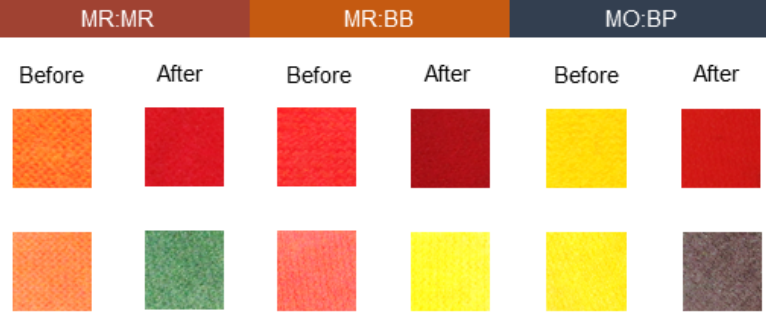
Figure 9. Sensitivity of cotton knits functionalized with different pH sensors to a basic environment created by 35% ammonia and hydrochloride acid solutions. The sensors used were: methyl red and bromothymol blue (MR:BB); methyl red and methyl red sodium salt (MR:MR); and methyl orange and bromocresol purple (MO:BP).